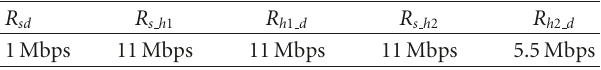
Table 5: Settings for study of Hello packet